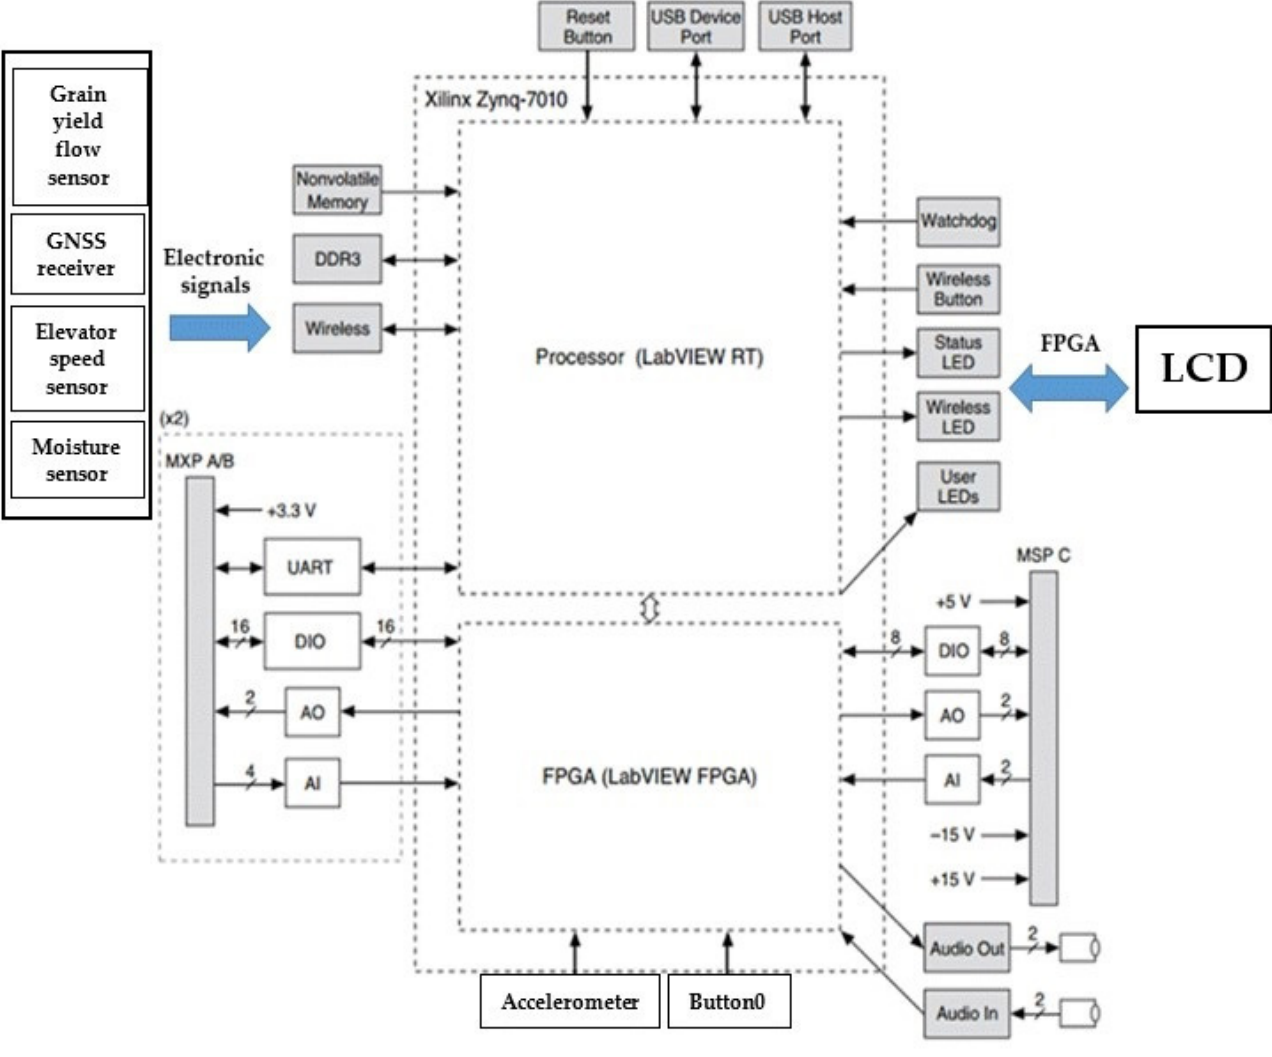
Figure 2. Data acquisition module.